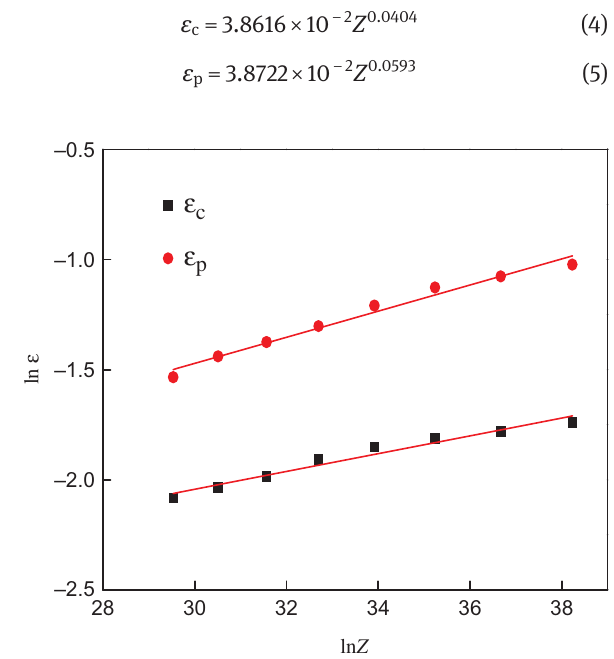
Figure 6: Relationships between critical strain ε c , peak stain ε p and Z.